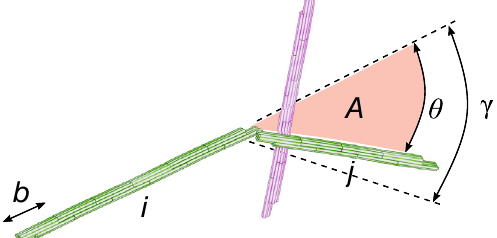
and τ (cid:4) from the common fit d